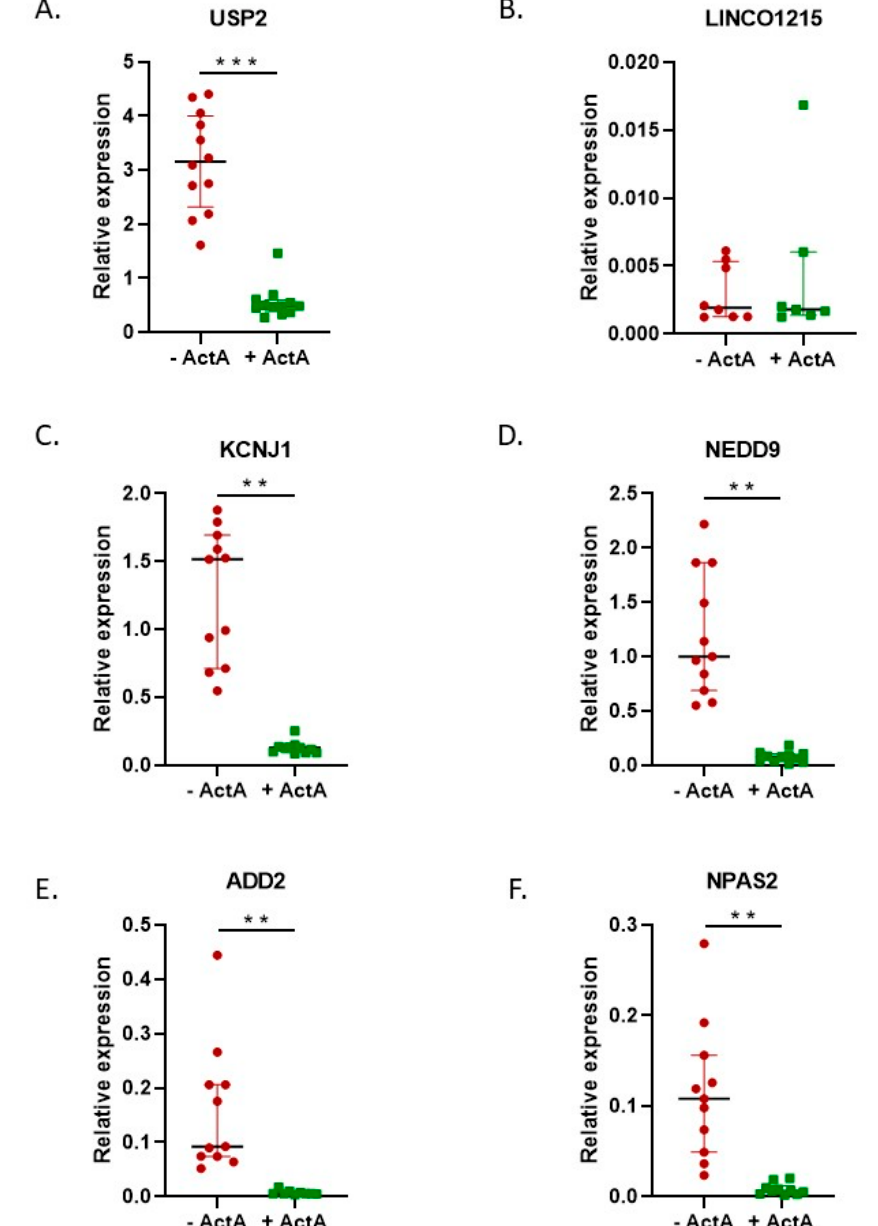
Figure 8. The qPCR confirmed the RNAseq data. The qPCR data for the most significantly differentially expressed genes depicted in the volcano plot. Data are presented as medians with the interquartile range. The qPCR data confirmed the RNA sequencing data. ( A – F ) qPCR of genes downregulated by Activin-A. − Activin-A, n = 11; +Activin-A, n = 11. Wilcoxon matched pairs signed rank test ** p < 0.01, *** p < 0.001.